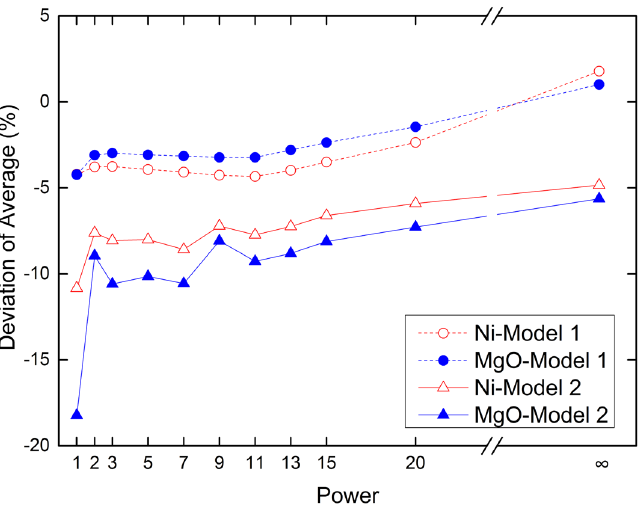
Figure 7. Deviation of average ore grade.